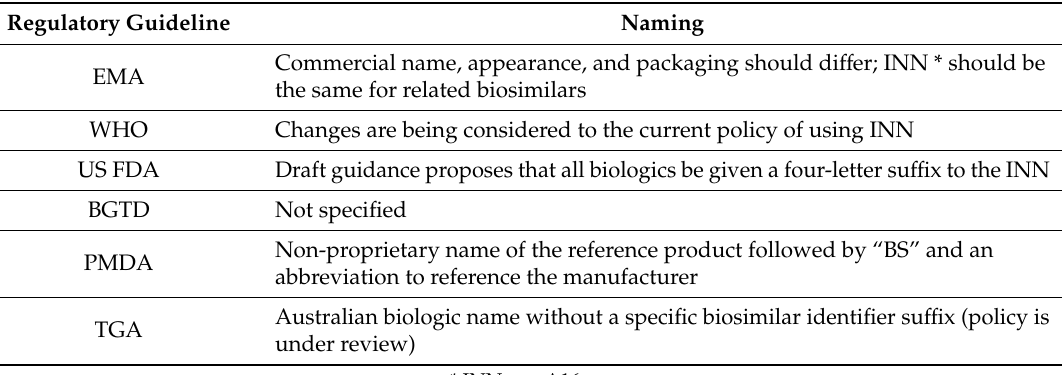
Table 3. Comparative overview for naming biosimilars between the regulatory guidelines of EMA, WHO, US FDA, BGTD, PMDA, and